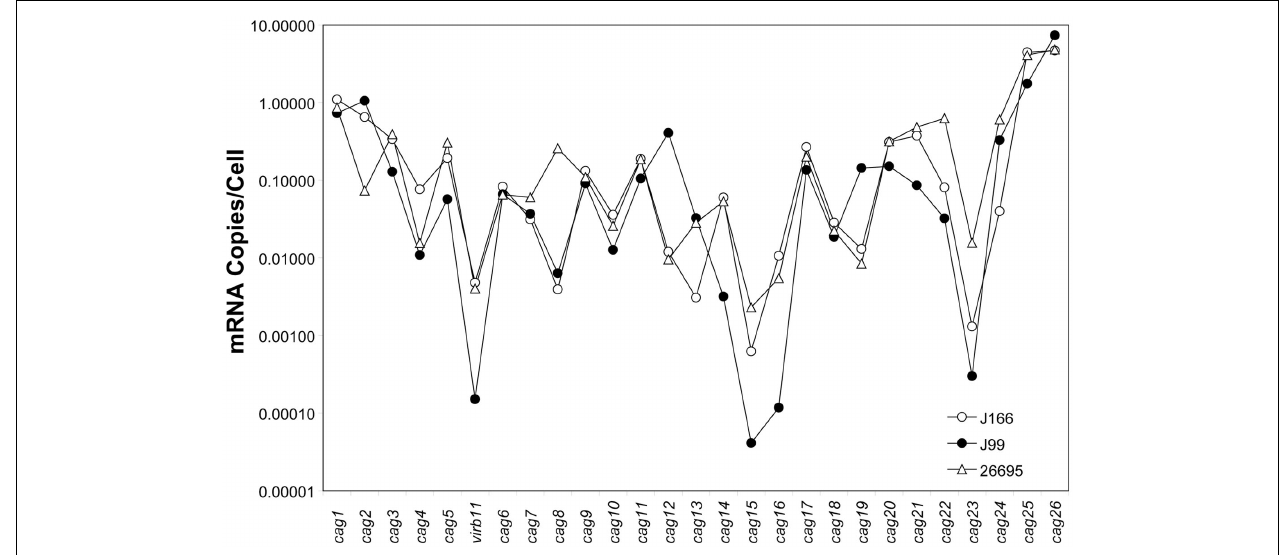
FIGURE 2 | Composite gene expression (mRNA copies/cell, normalized to 16S rRNA) for each gene on the cag PAI of H. pylori strains J166 (open circles), J99 (closed circles), and 26695 (open triangles). Our data represents the average of duplicate